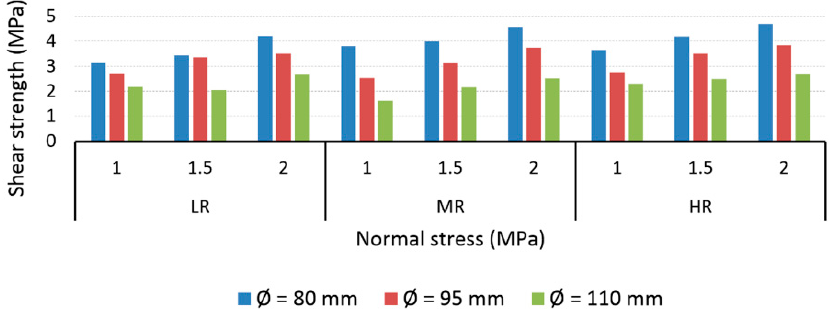
Figure 7. Shear strength of J&Br specimens embedding single joint with different sizes and roughness under different normal stress levels.